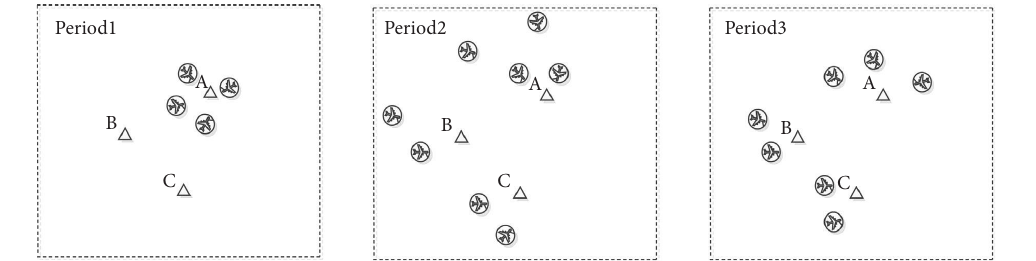
Figure 6: Simple scene diagram. Table 3: Flight simulation data for three periods.